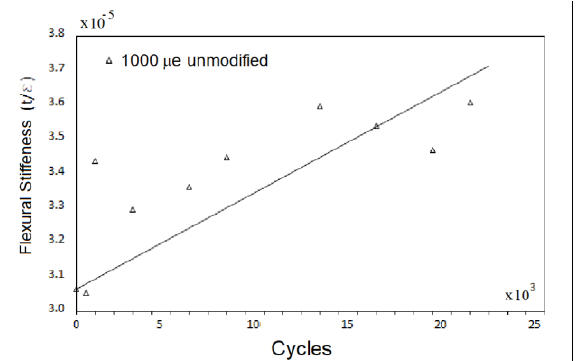
Figure 11. Evolution of flexural stiffness in panel unmodified F up to 0.27 × 10 5 impact cycles with P = 420 kN/m 2.